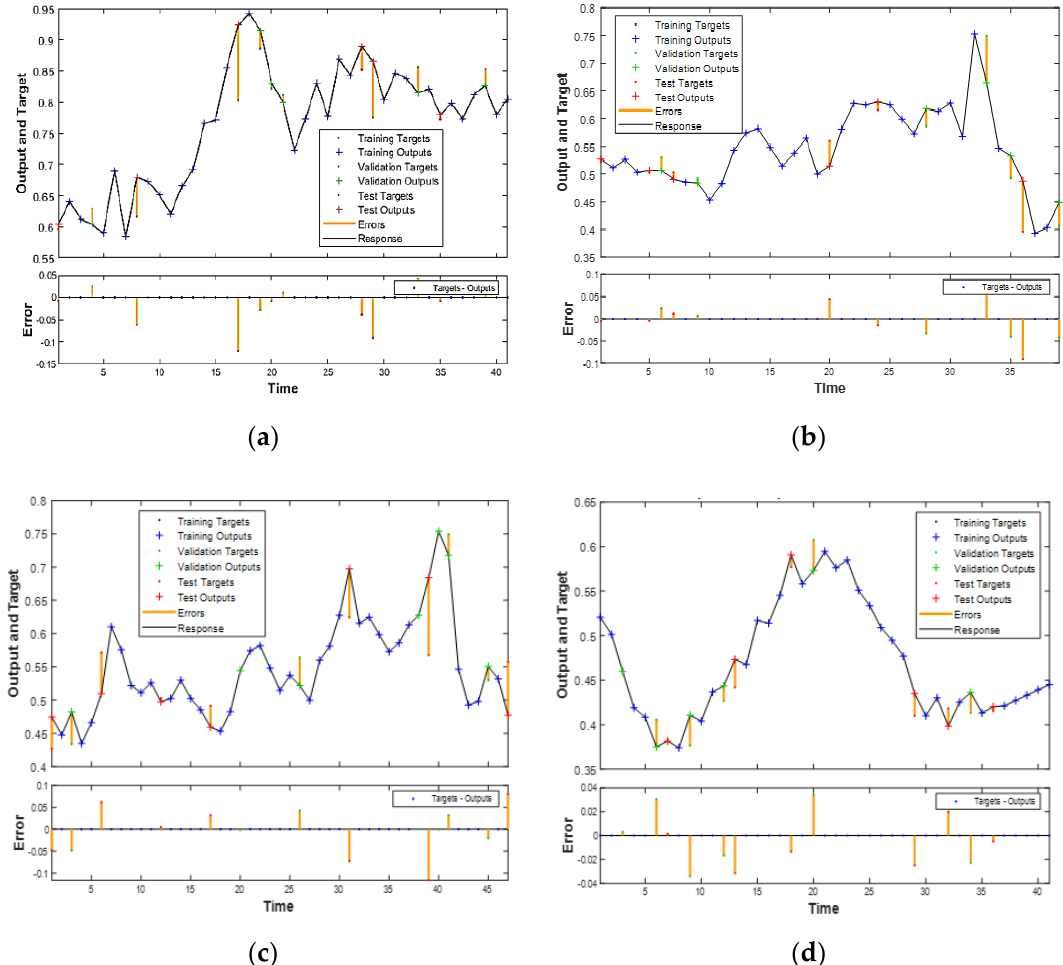
Figure 7. Comparison between the training, validation and testing responses of the NARX model. ( a ) Malaysia ( b ) Thailand, ( c ) Indonesia, ( d ) Philippines. Table 7. Comparison of the present work with literature.